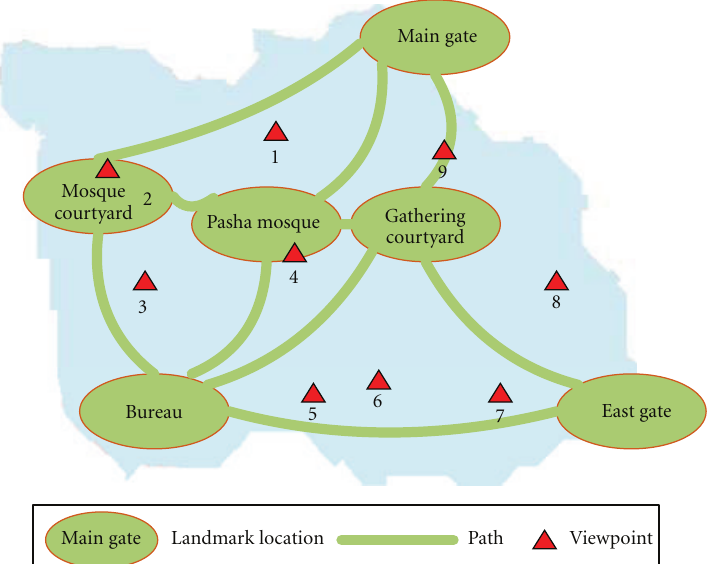
Figure 6: Damascus Poor District: topographical view.